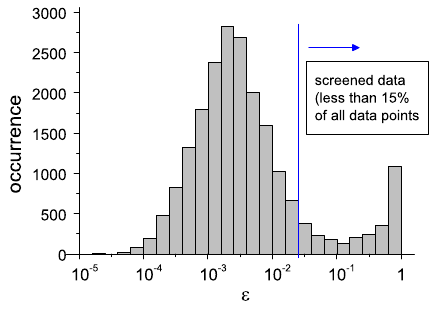
Fig. 2. Histogram for the values of (cid:15) as determined from all MFRSR PWV data of 2005–2009, which is used for data post- processing. We define the data with (cid:15) > 10 − 1 . 6 as not